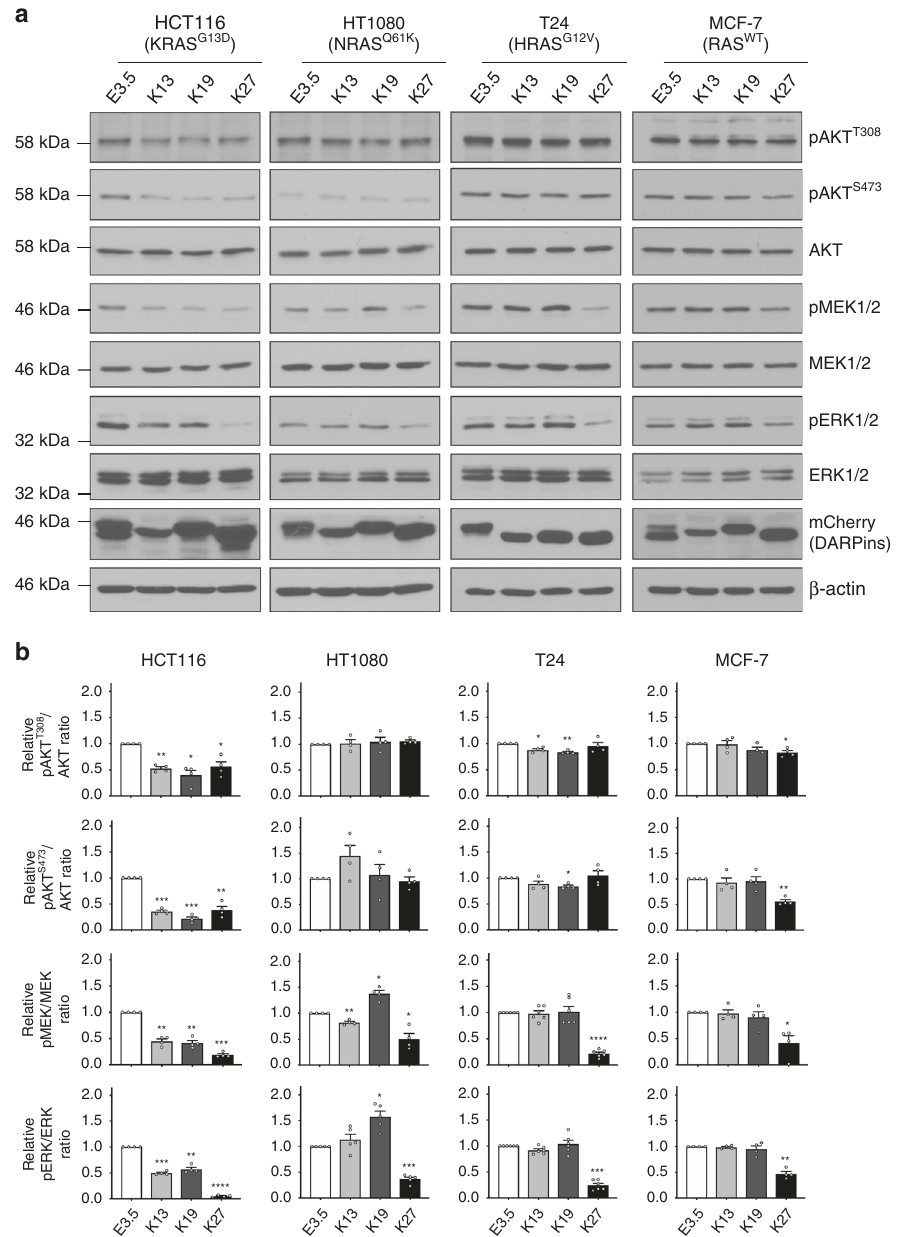
Fig. 5 K13/K19 inhibitory potency in cells. a Western blot analyses of the activation state of the RAF/MEK/ERK and PI3K/AKT pathways in cancer cell lines bearing or not a mutated RAS upon overexpression of the DARPin-mCherry fusions. E3.5 is a negative and DARPin K27 is a positive control. b Quanti fi cations of pERK/ERK, pMEK/MEK and pAKT/AKT signals from ( a ). These signals were normalised to the negative control DARPin E3.5. Statistical analyses in b were performed using a one-way ANOVA followed by Dunnett ’ s post-hoc tests (* P < 0.05, ** P < 0.01, *** P < 0.001, **** P < 0.0001). Each experiment was performed at least four times ( a – b ). Error bars are mean ± SEM of biological repeats ( b ). a , b Source data are provided as a Source Data fi